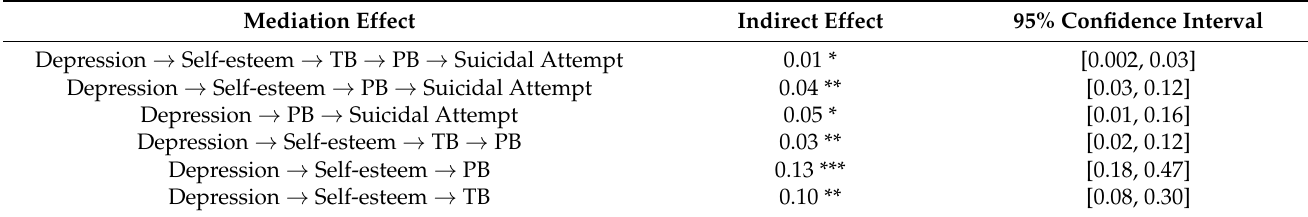
Figure 1. The mediating effect of self-esteem and interpersonal needs in the association between depression and suicidal attempt. * p < 0.05, ** p < 0.01, *** p < 0.001. Table 4. Estimated mediation effects of self-esteem and interpersonal needs in the association between depression and suicidal attempt.